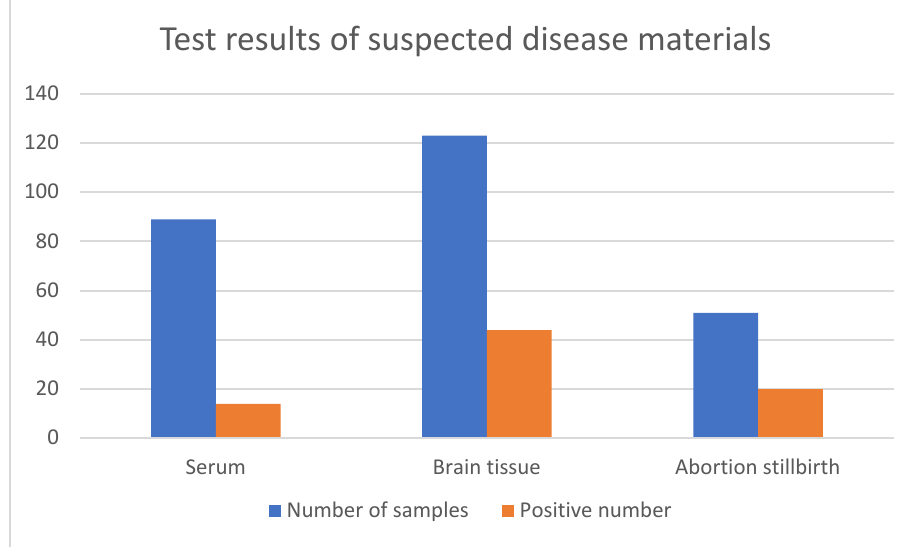
Figure 1. The results of detecting suspected JEV materials in South China from 2011 to 2018. Blue represents the total number of tests, and orange represents the number of positive samples.